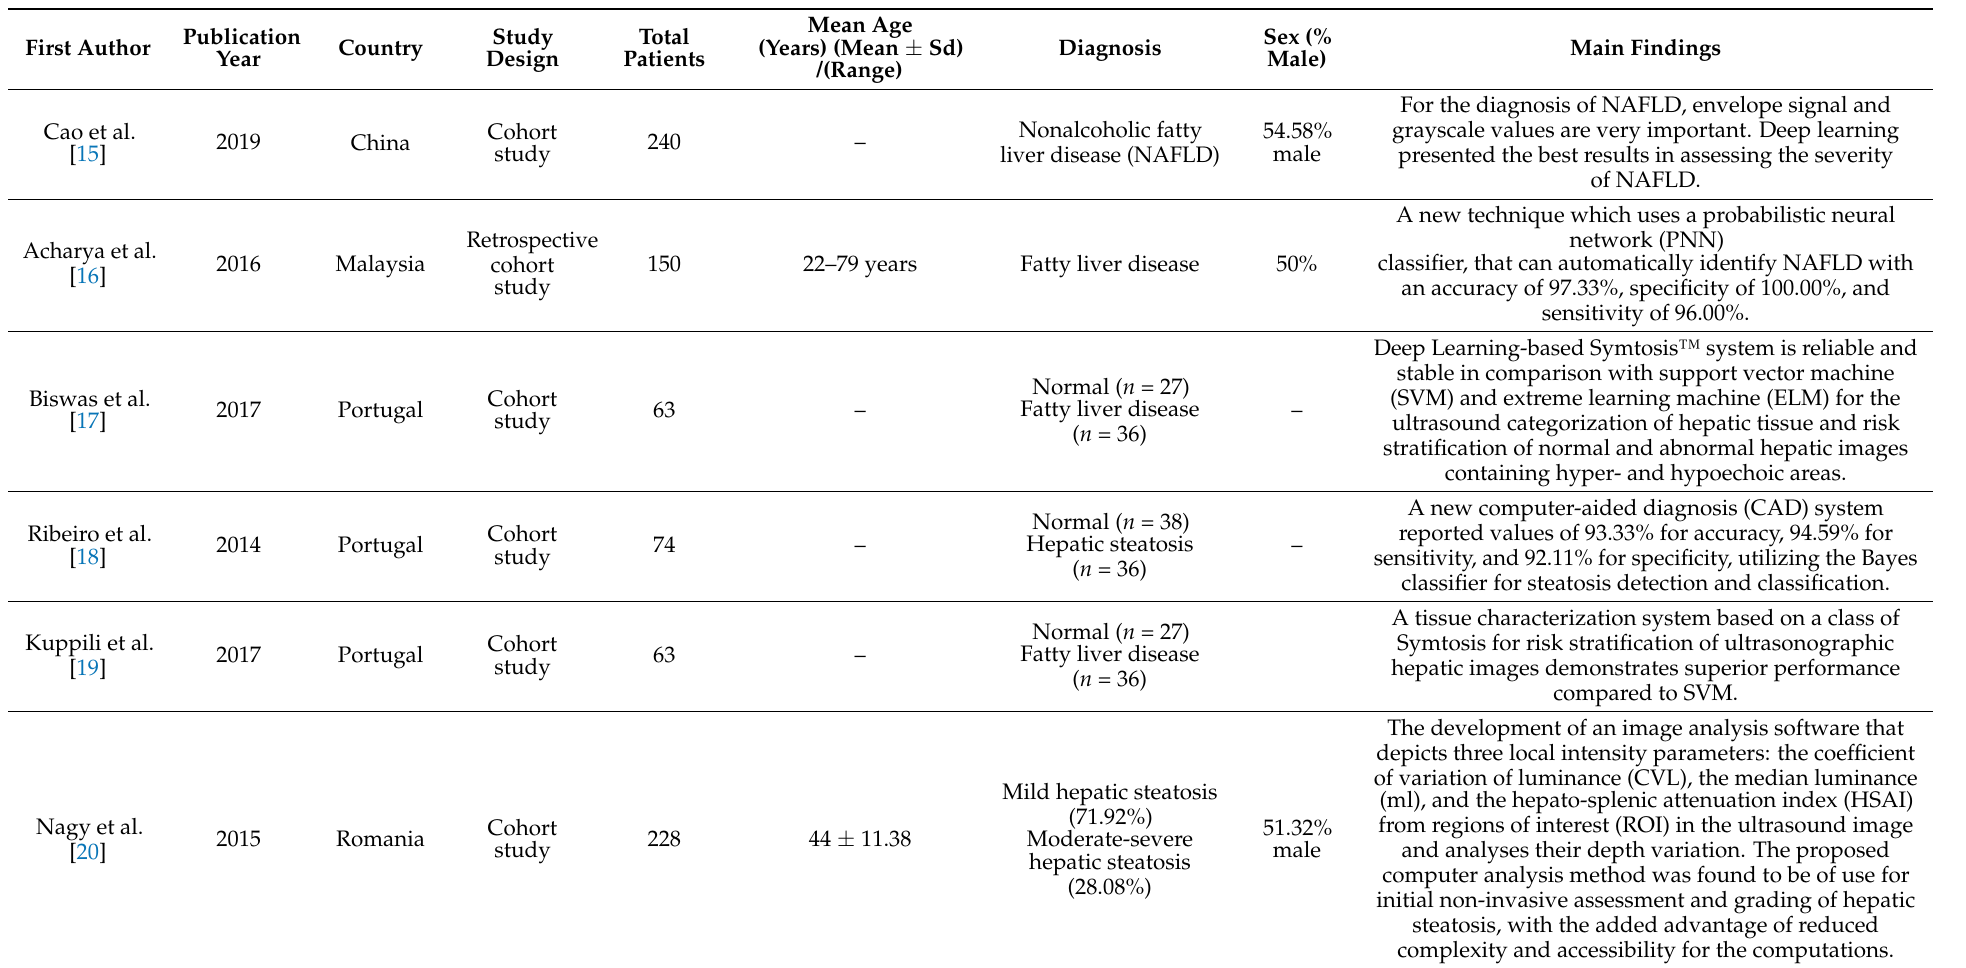
Table 1. Studies assessing artificial intelligence-based